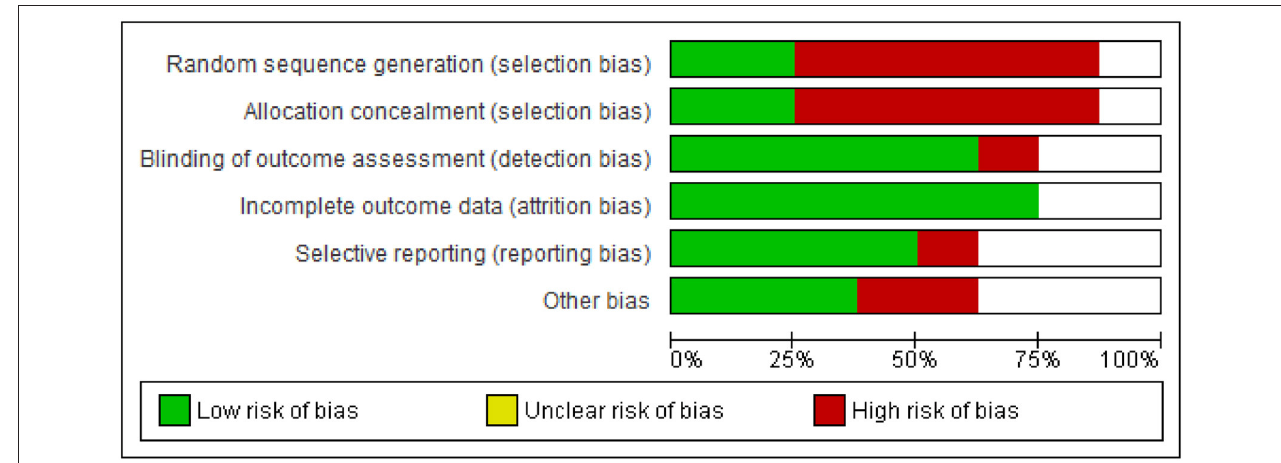
FIGURE 4 | Risk of bias across all included